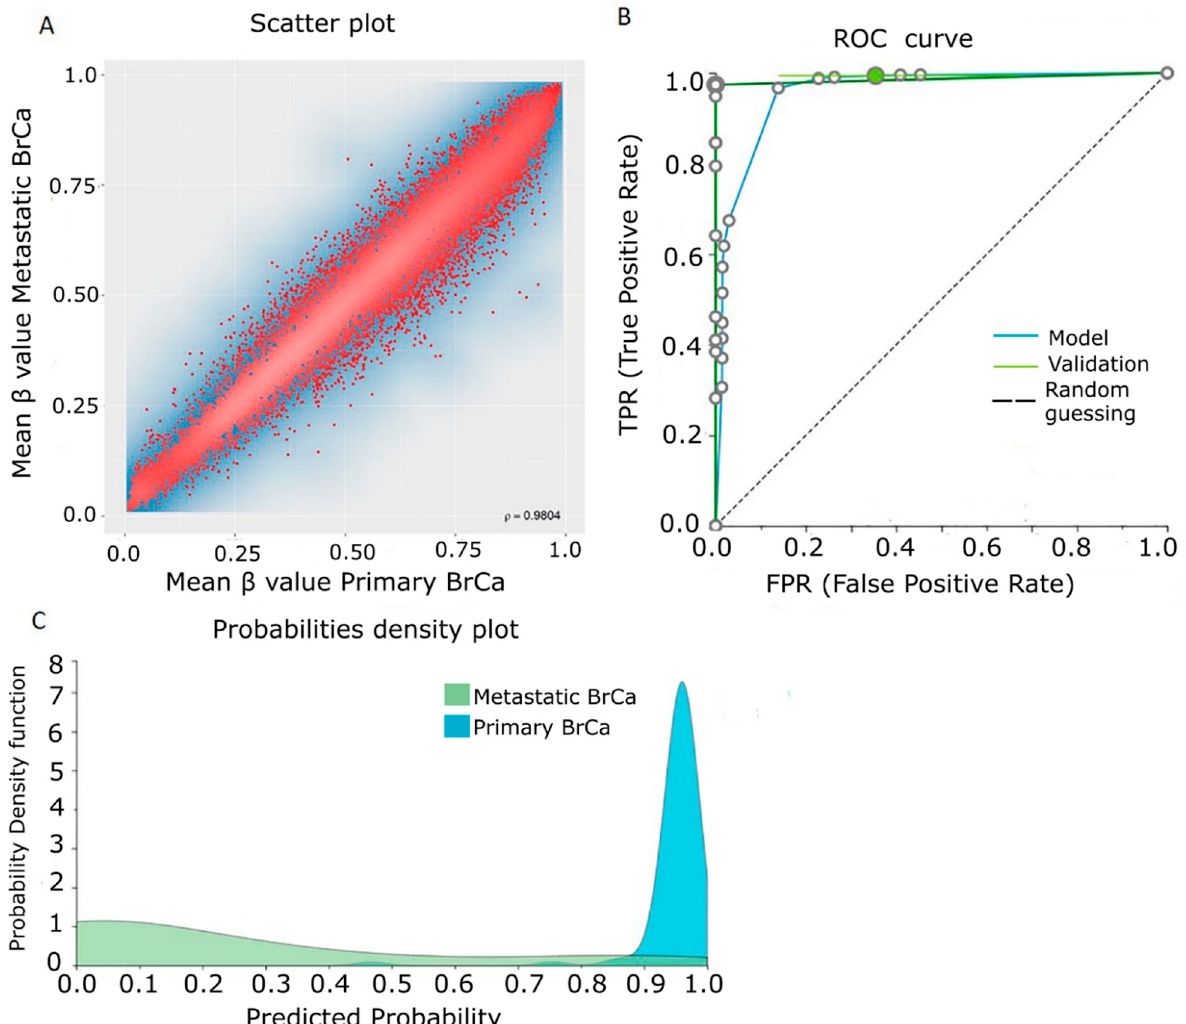
Figure 3. Differential methylation between primary and metastatic BrCa. ( A ) Scatterplot showing mean β value for each gene among primary BrCa and metastatic BrCa. ( B ) ROC curves of training (blue line) and validation (green line) models. ( C ) Probability density plot depicting distinct distributions among studied classes of training group. Abbreviations: BrCa = breast cancer, DMGs = differentially methylated genes, ROC = receiver operating